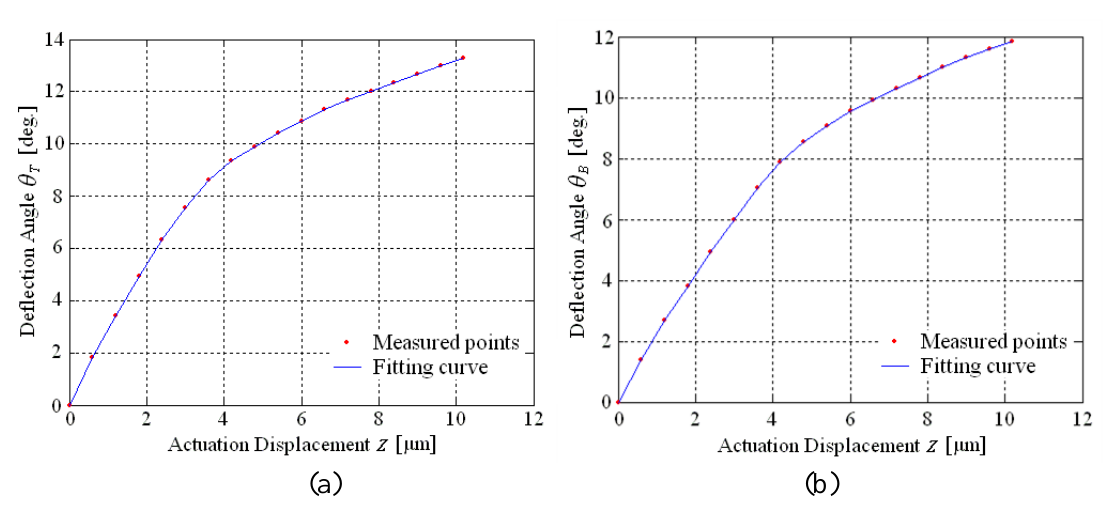
Figure 8. Deflection angles characteristics in two directions. (a) deflection angle θ twisting direction, (b) deflection angle θ